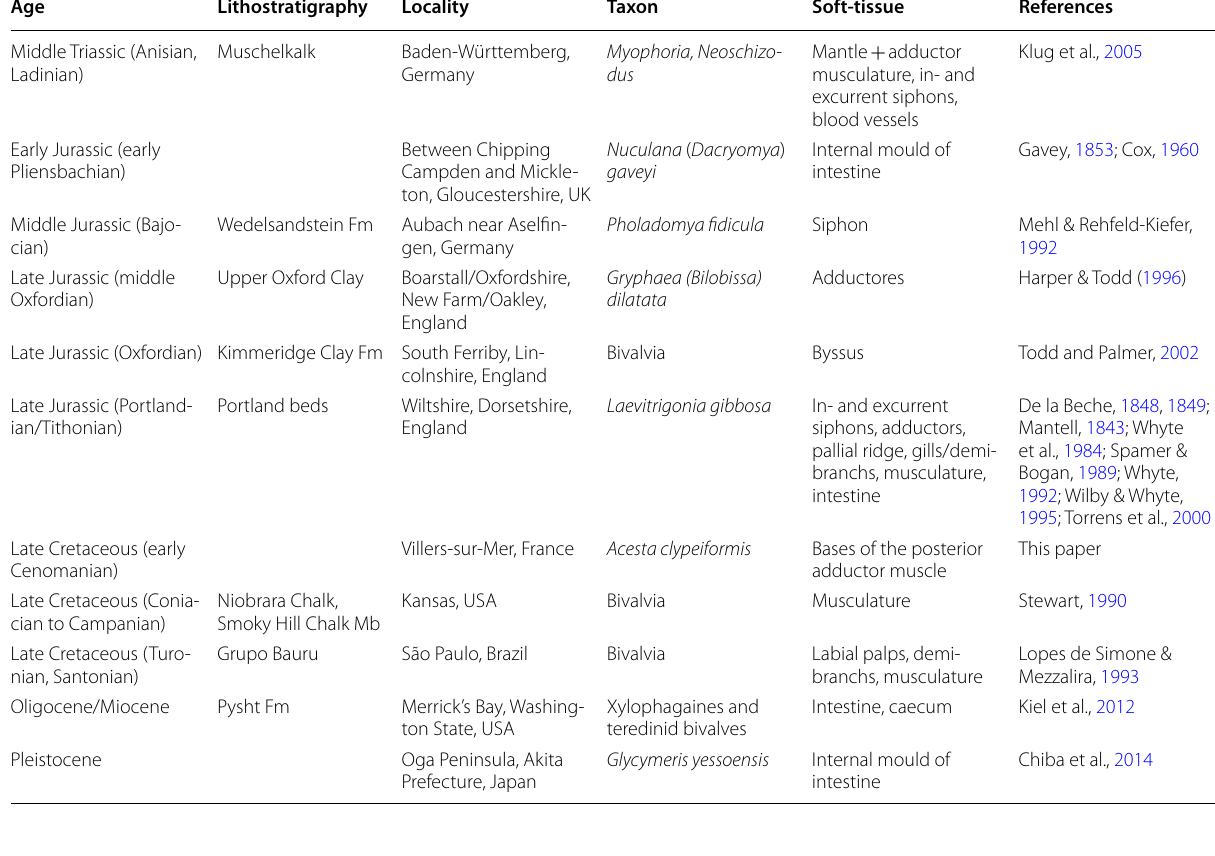
Table 1 List of occurrences of fossilized soft tissues in bivalves (modified after Klug et al., 2005)